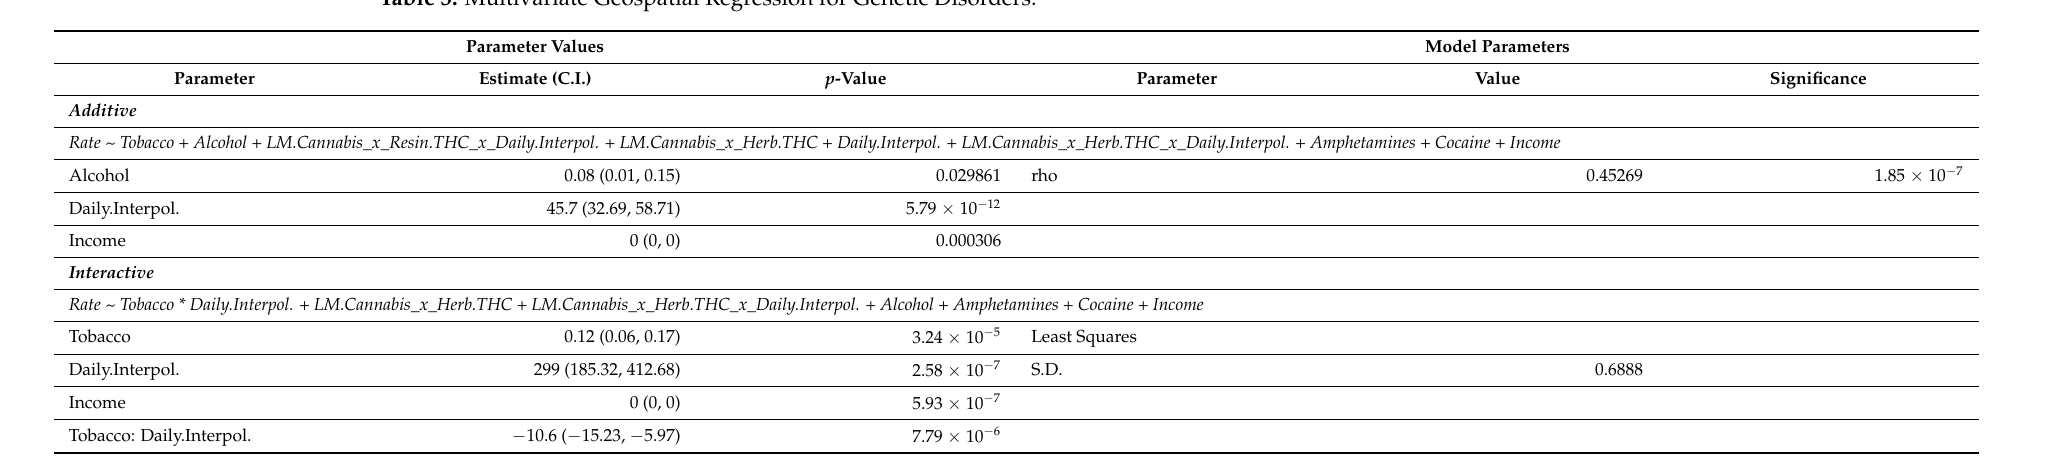
Table 3. Multivariate Geospatial Regression for Genetic